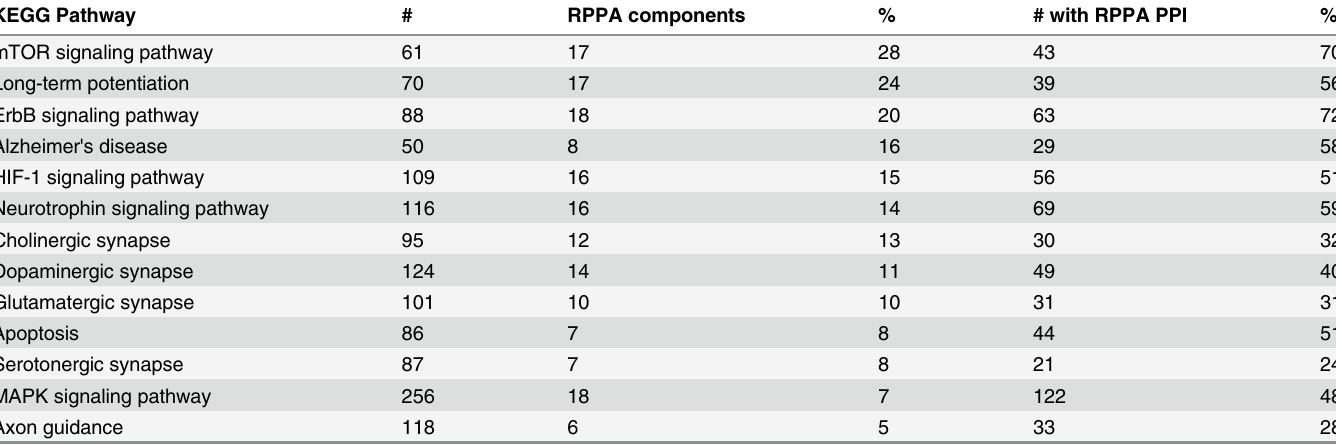
Table 6. SOM discriminating proteins are enriched in pathways relevant to neurological function. KEGG